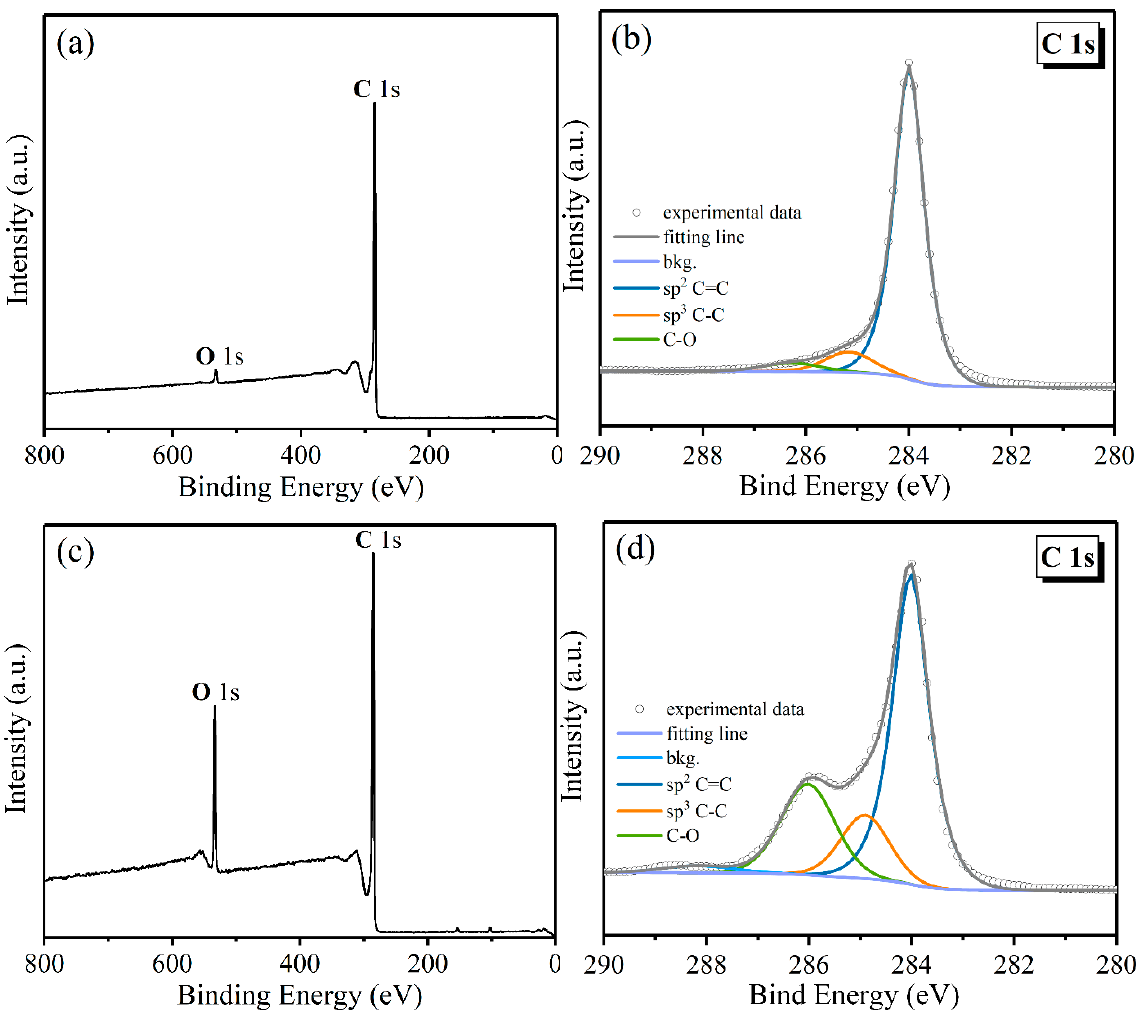
Figure 4. XPS scans for ( a ) GNPs and ( b ) CNT@X+GNPs fillers and ( c , d ) their high-resolution scan spectra of C 1s peaks. Table 2. Atomic concentration of elements in GNPs and CNT@X+GNPs.